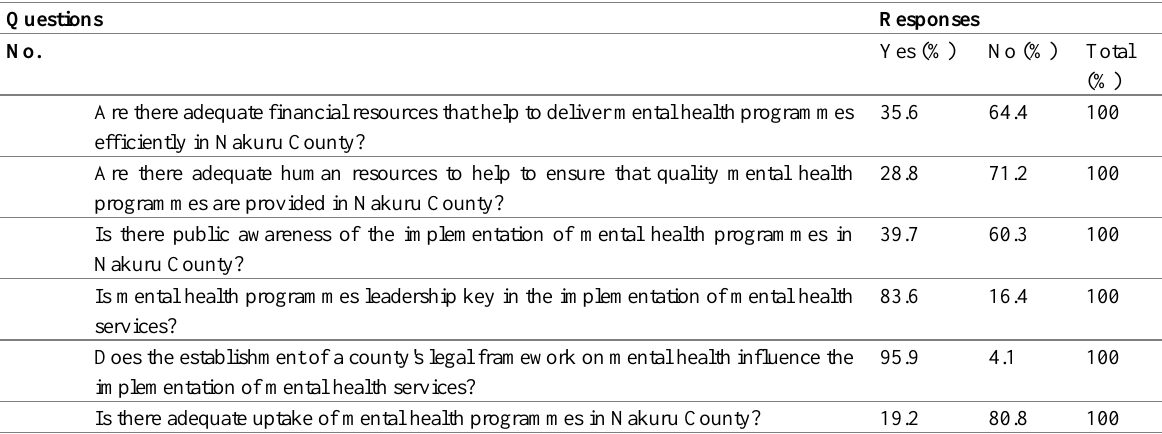
Table 2: Implementation of Mental Health